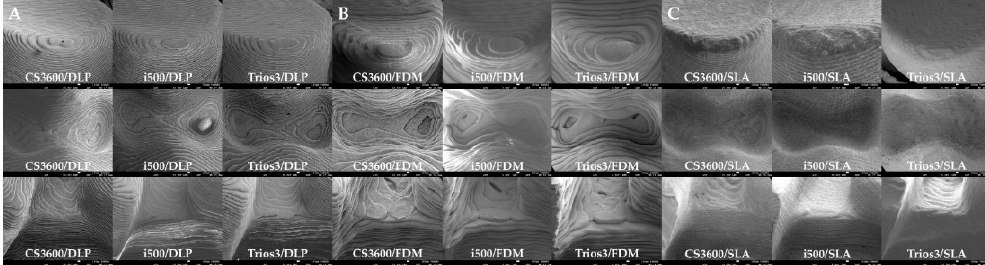
Figure 6. ( A ) DLP, ( B ) FDM, and ( C ) SLA each of the 3D printed models-SEM images at the three type surface characteristics of the models in the layer thickness density and shape by layer technique for qualitative evaluation (original magnification 30×).